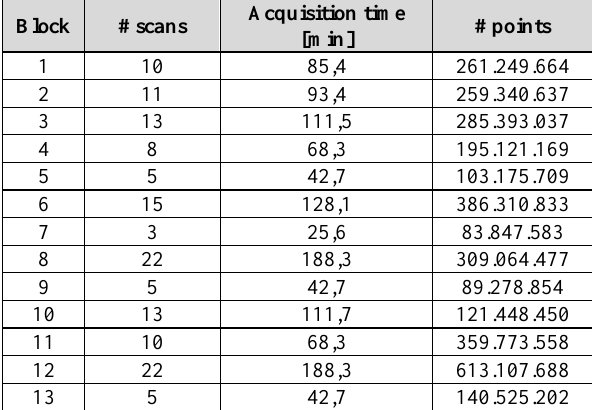
Table 3. TLS acquired dataset